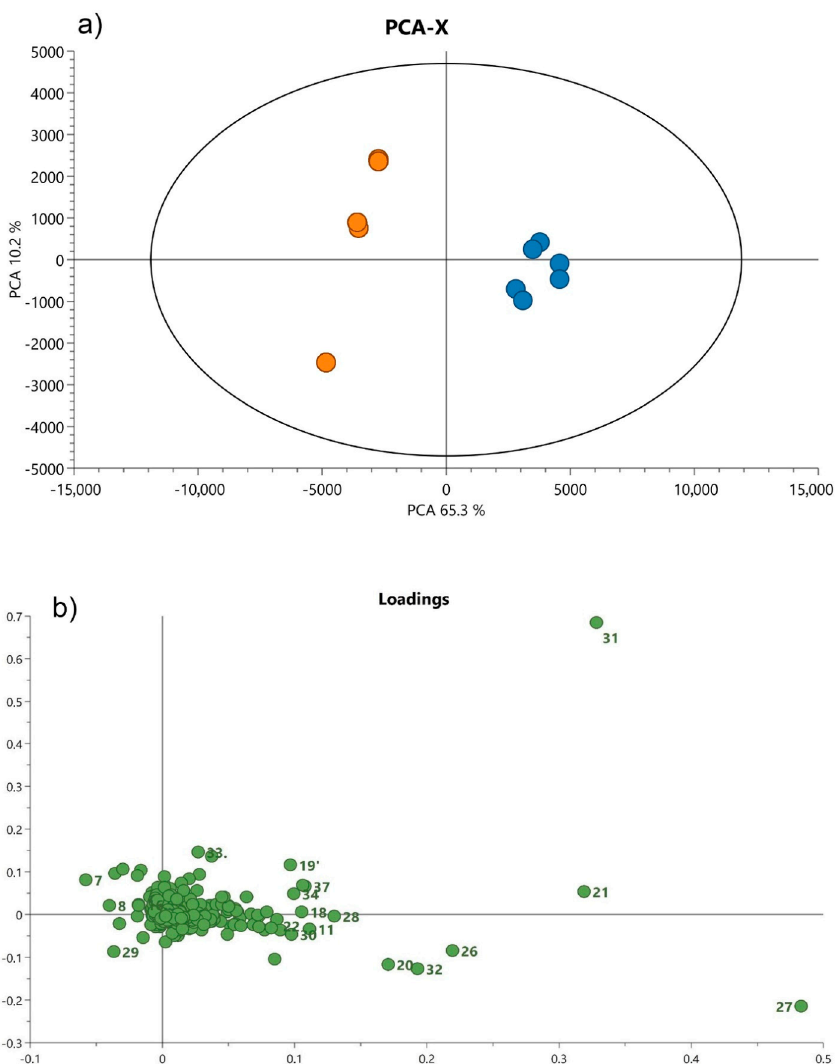
Figure 4. Principal component analysis presenting the relationship between the chemical profile of the main compounds in the root and species annotation of the analyzed plants; S. yangii (blue) and S. abrotanoides (orange) ( a ), with corresponding loadings (PCA model: R 2 X Cum = 0.755, Q 2 Cum = 0.566) ( b ). Each loading number corresponds to the peak number identified in the BPC